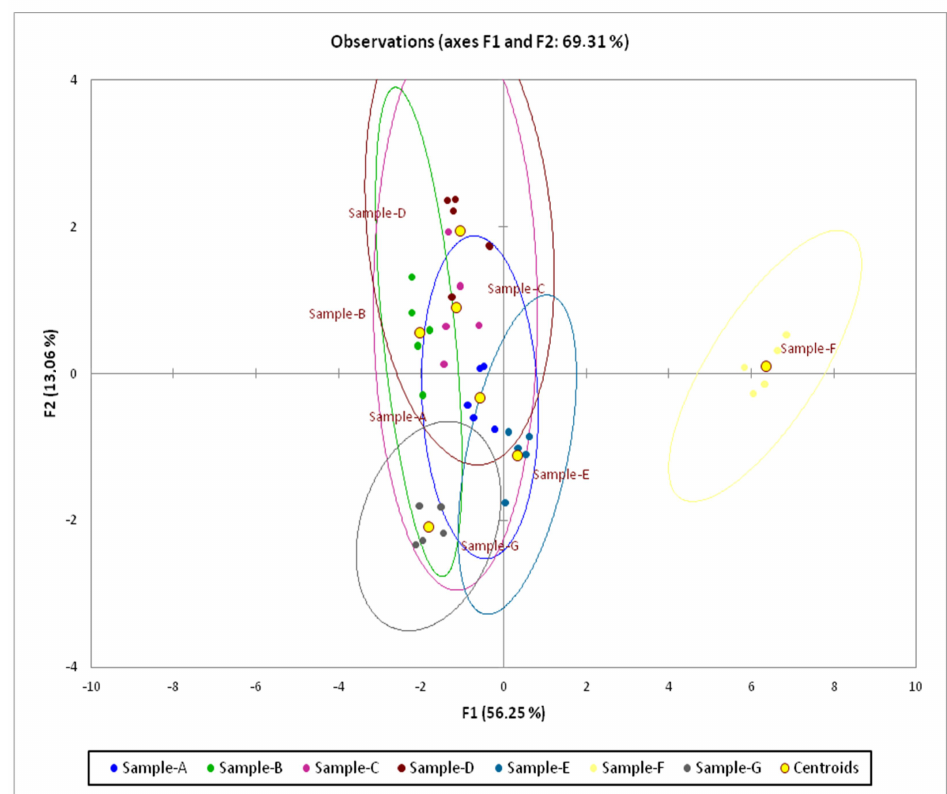
Figure 4. PCA plot of the wines